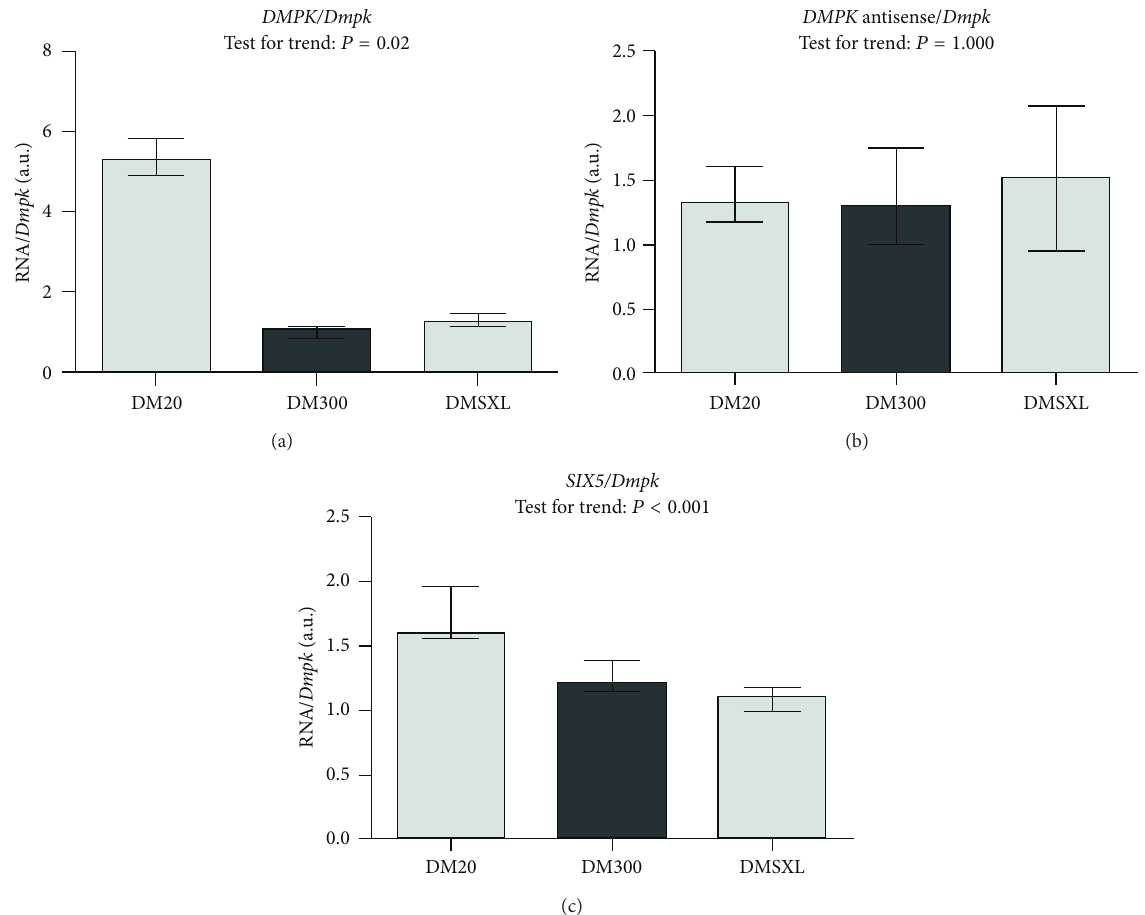
Figure5:DecreasedsensetranscriptlevelsattheDM1locusinthepresenceofexpandedCTG-repeats.UponCTG-repeatexpansion,decrease of DMPK sense and SIX5 transcript levels is observed, while DMPK antisense levels are unaffected by CTG-repeat length. These graphs show relative abundance (in arbitrary units) of transcripts of interest, corrected by two different reference genes ( 18s (a) and endogenous murine Dmpk (b)). Height of bars indicates the median enrichment, and error bars indicate the interquartile range (25th to 75th percentile